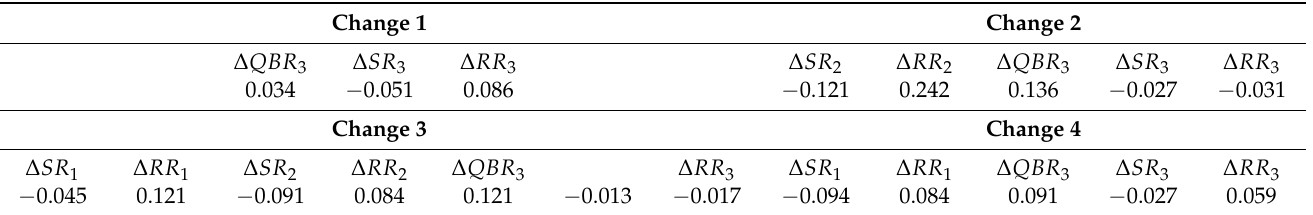
Table 5. Simulation results for the different change